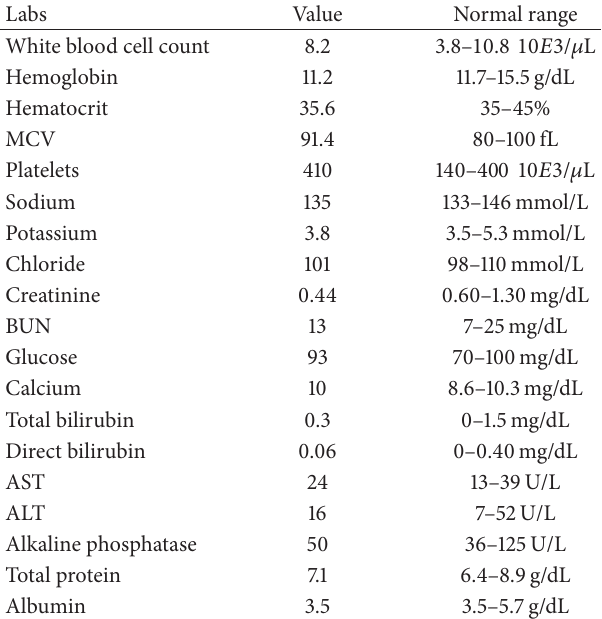
Table 3: Other laboratory results.